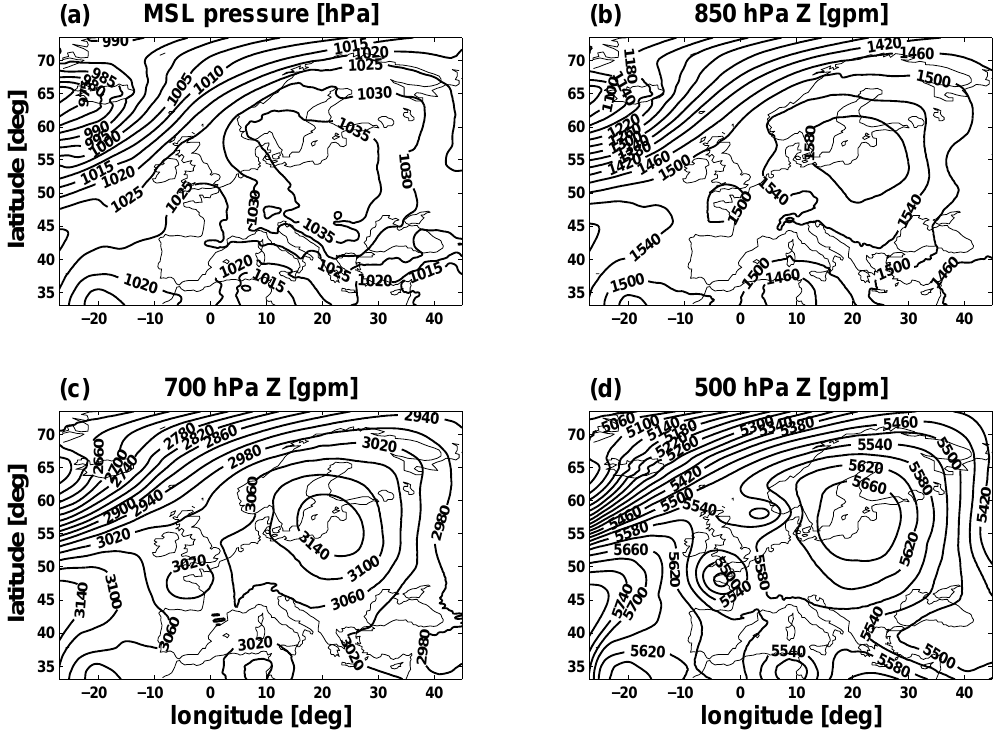
Fig. 2. The ECMWF analysis fields of (a) MSL pressure, (b) 850hPa, (c) 700hPa and (d) 500hPa geopotential height at 00:00UTC 9 January 2006.